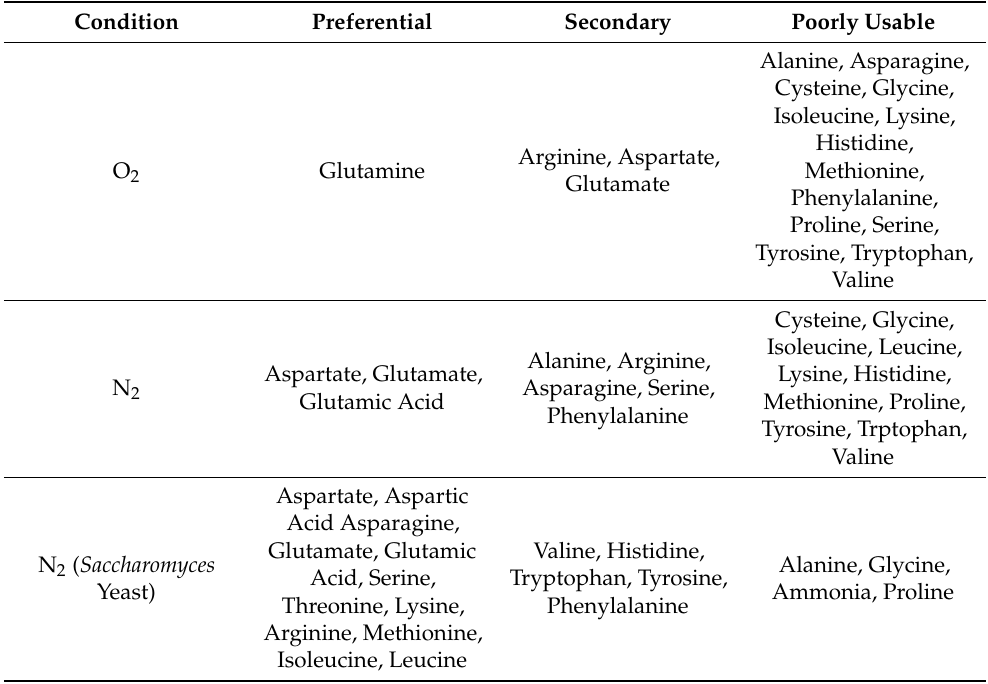
Table 7. Classification of amino acids by their potential to promote the growth of Brettanomyces bruxellensis GDB 248 in aerobiosis or in anaerobiosis